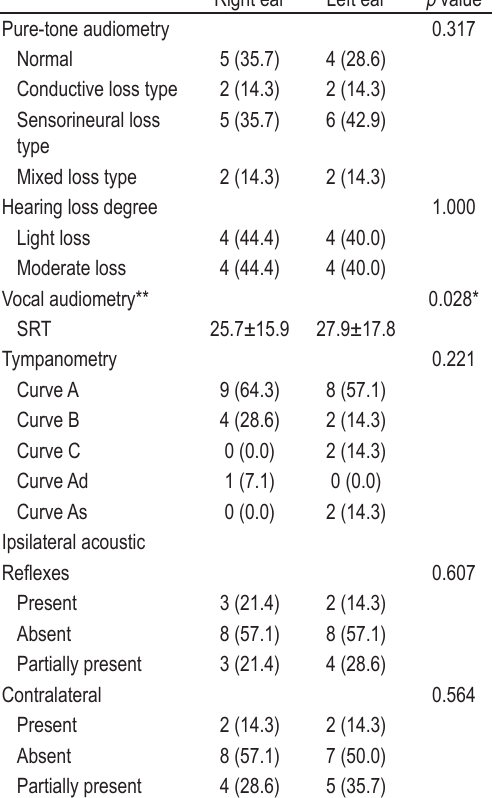
TABLE 1. Peripheral auditory evaluation findings and p value for the left and right ear regarding pure tone audiometry, type and degree, vocal audiometry, tympanometry, and acoustic reflexes